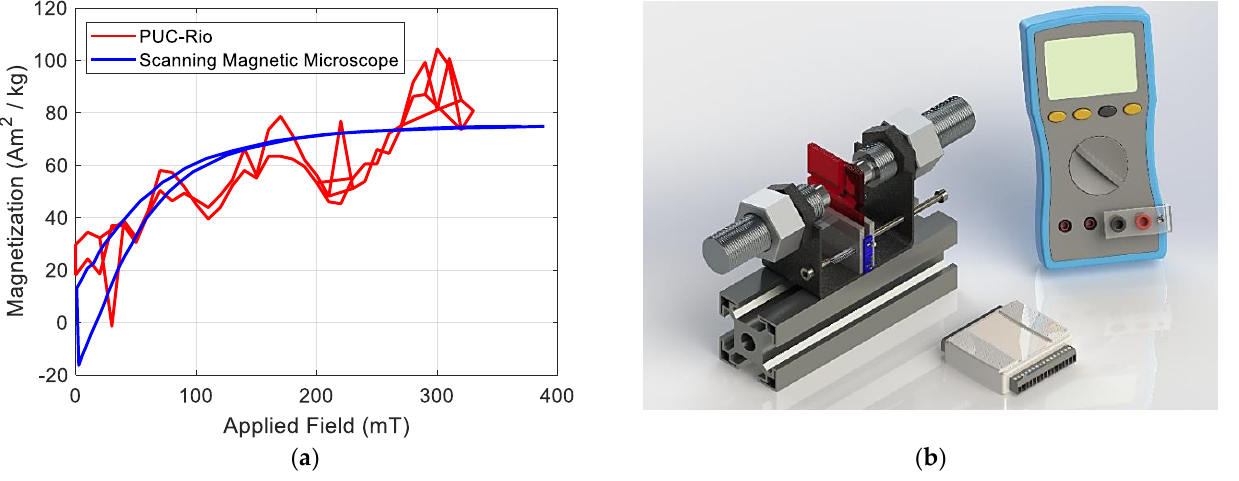
Figure 7. ( a ) Continuous curve in the red color of the sample of magnetite microparticles, obtained in the magnetometer built at PUC-Rio, and continuous curve in the blue color of the sample of magnetite obtained in the scanning magnetic microscope. ( b ) Figure representing a model of a magnetometer using a data acquisition board.